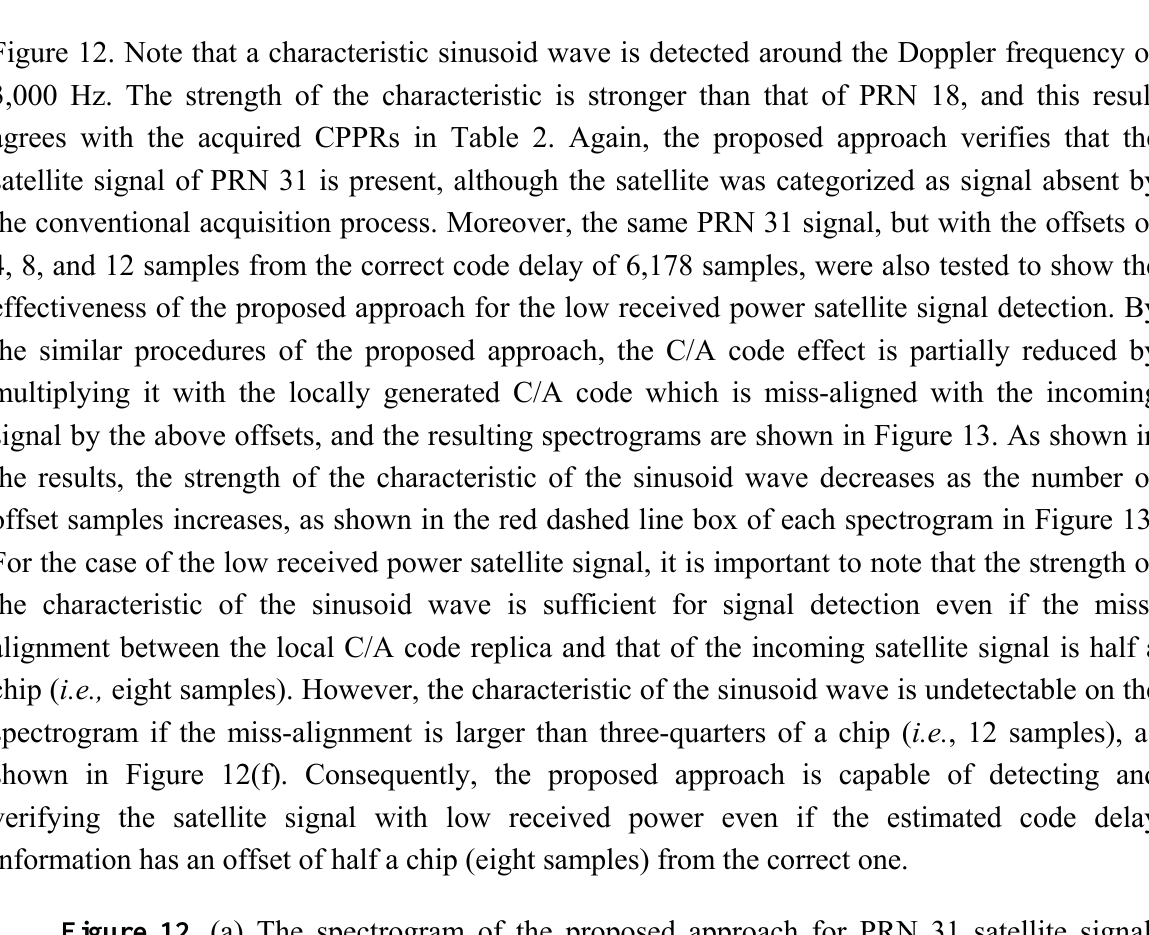
Figure 12. (a) The spectrogram of the proposed approach for PRN 31 satellite signal. (b) The top view of (a), a characteristic sinusoid wave can be observed around the frequency of 3,000